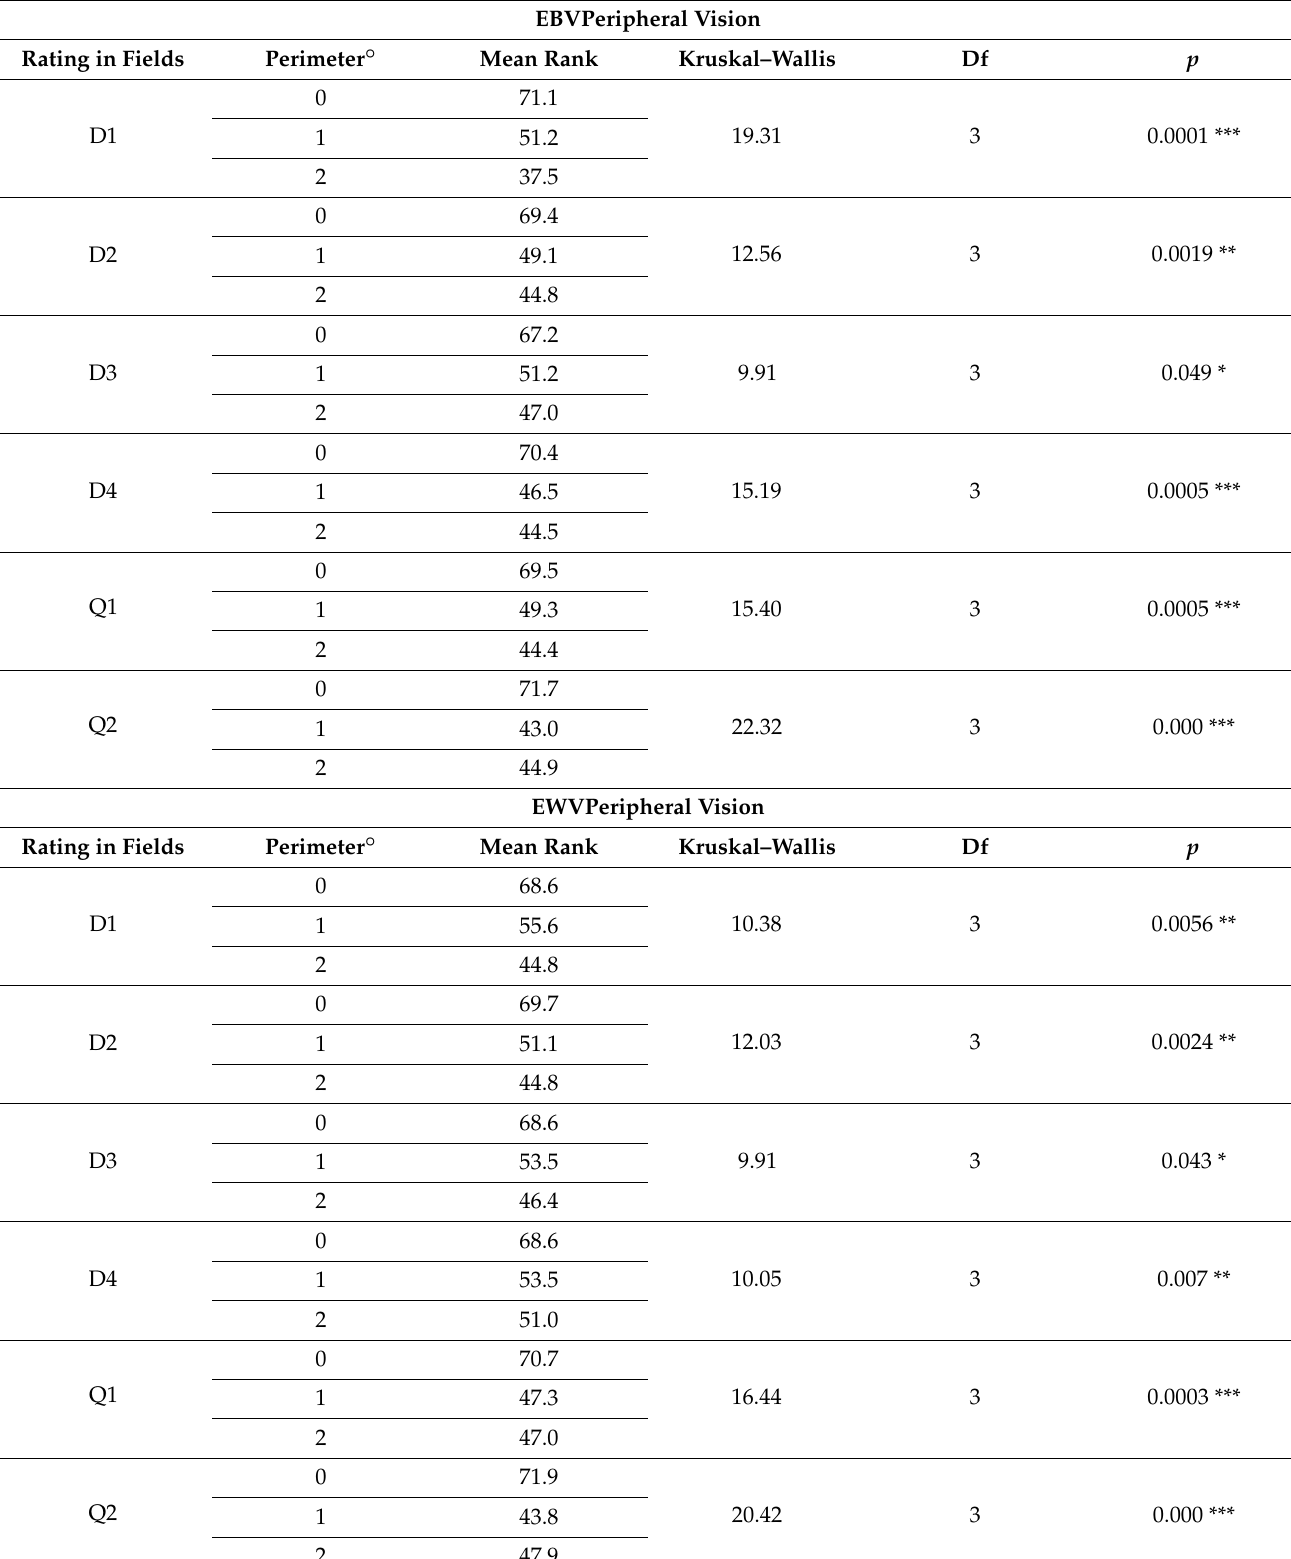
Table 6. Statistical evaluation of WHOQOL-BREF by Kruskal–Wallis test of the EBV and EWV: peripheral vision. EBVPeripheral